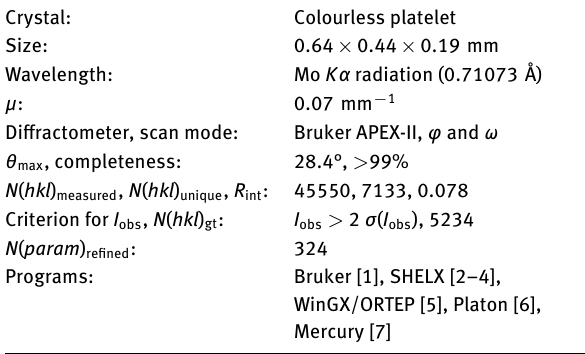
Table 1: Data collection and